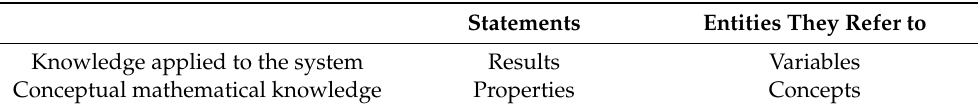
Table 1. Classification of the statements and entities in the mathematization, as organized in this paper (source: prepared by the